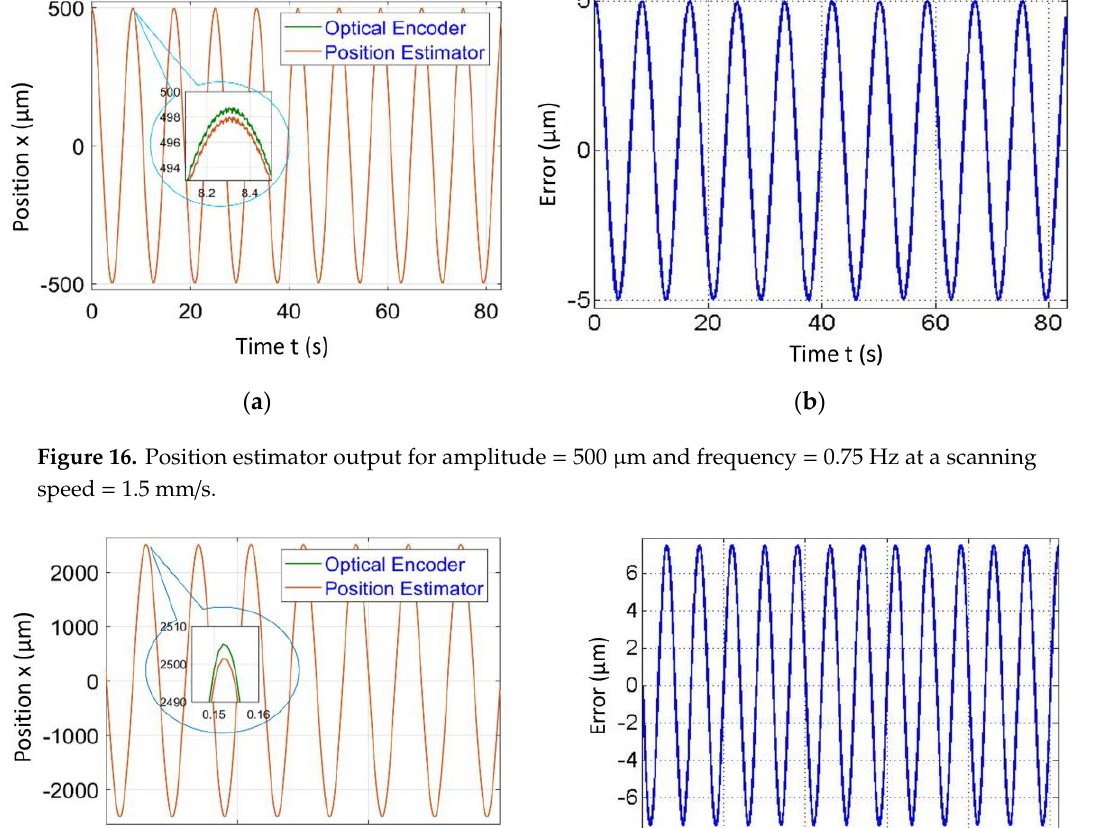
Figure 17. Position estimator output for amplitude = 2500 µm and frequency = 5 Hz at a scanning speed = 50 mm/s.